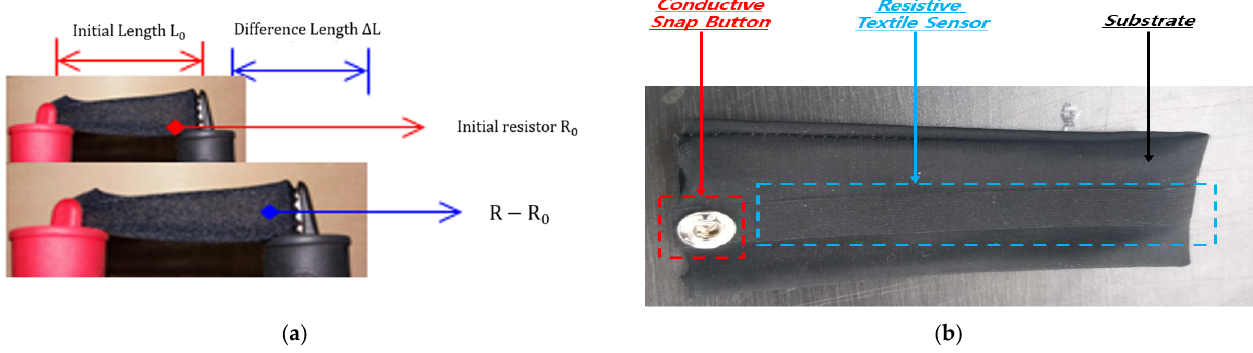
Figure 2. E-textile characteristics: ( a ) Gauge ratio test with gauge factors; ( b ) Resistant fiber sensor appearance.